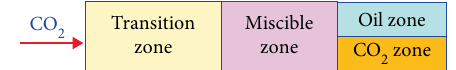
Figure 17: The zone schematic during long core displacement